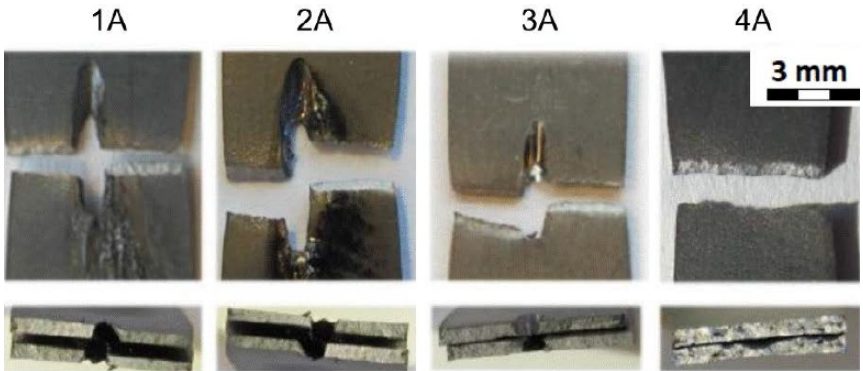
Figure 11. Fracture areas and fracture surfaces of individual sample groups—Material thickness 0.5 mm; Tests at room temperature.